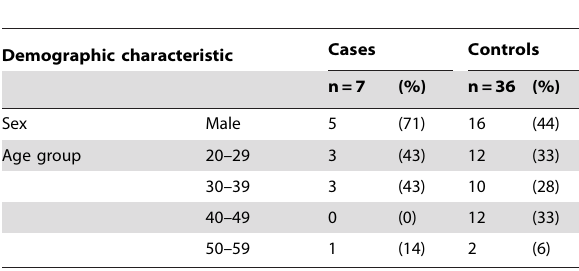
Table 1. Demographic characteristics of study subjects, Papua New Guinea,